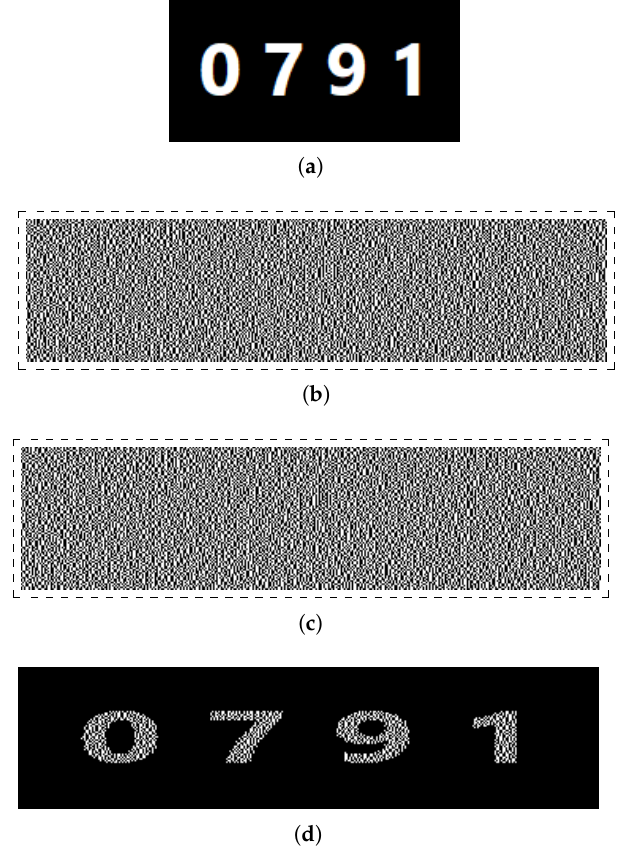
Figure 3. Results obtained from a presented conventional pixel-based VC version. Key images (shares) appear like dense salt-and-pepper noise. ( a ) Secret image (a numeric code); ( b ) generated Key Image 1 (Share 1); ( c ) generated Key Image 2 (Share 2); ( d ) superposed key images (stacked